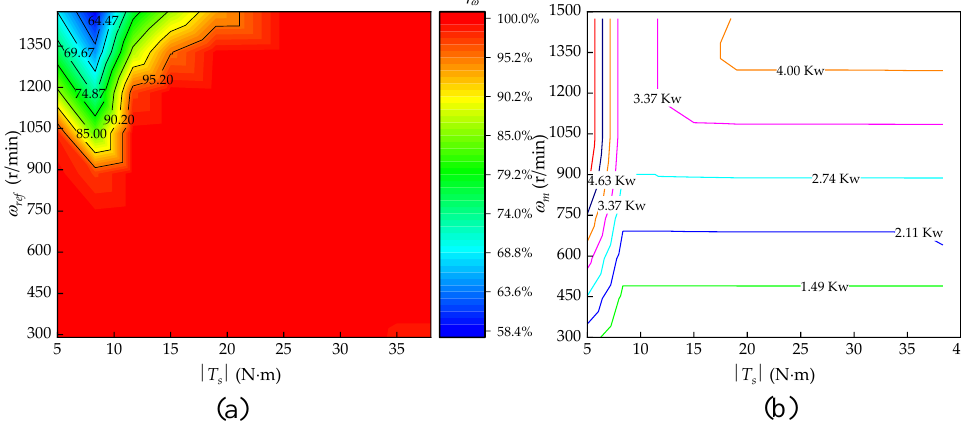
Figure 11. ( a ) Speed accuracy map for EPCBV system, ( b ) power consumption map for EPCBV sys-